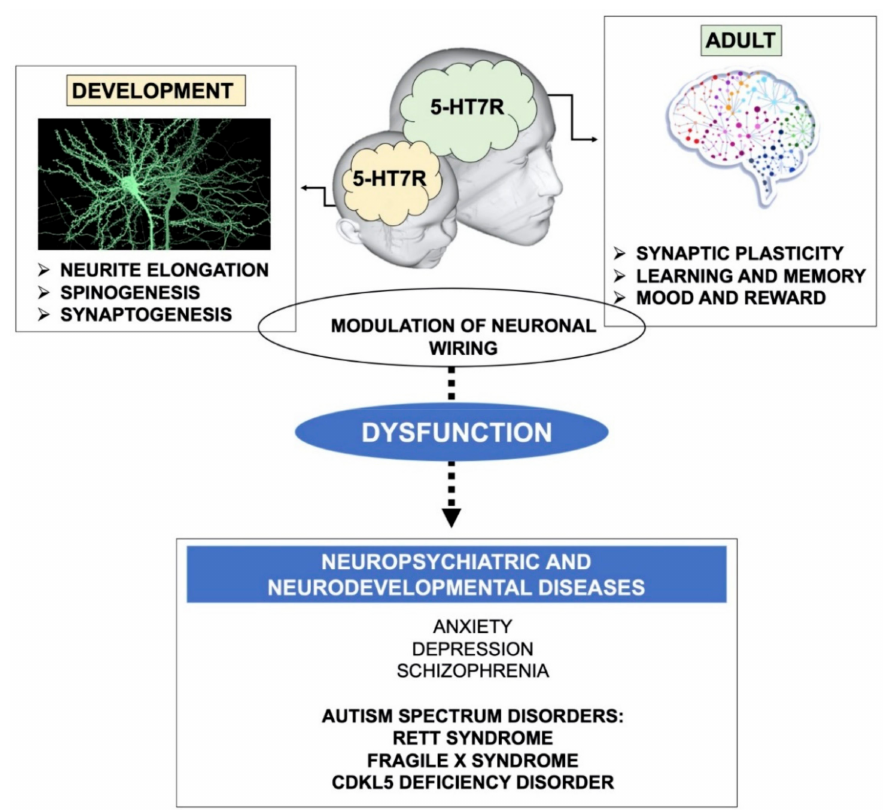
Figure 1. Schematic drawing illustrating the role of the 5-HT7R in brain plasticity and connectivity. During development, the 5-HT7R contributes to proper neuronal wiring through the stimulation of neurite elongation, growth and maturation of dendritic spines, and synaptogenesis. During adulthood, the 5-HT7R signaling stimulates synaptic plasticity (LTP, LTD and structural remodeling of neuronal connections), which in turn affects many physiological functions, such as learning, memory, mood and reward. Dysregulated 5-HT7R signaling was demonstrated in neuropsychiatric and neurodevelopmental diseases characterized by altered brain connectivity. Notably, 5-HT7R stimulation exerts a widespread beneficial effect on behavioral and molecular alterations in various mouse models of Autism Spectrum Disorders (highlighted in